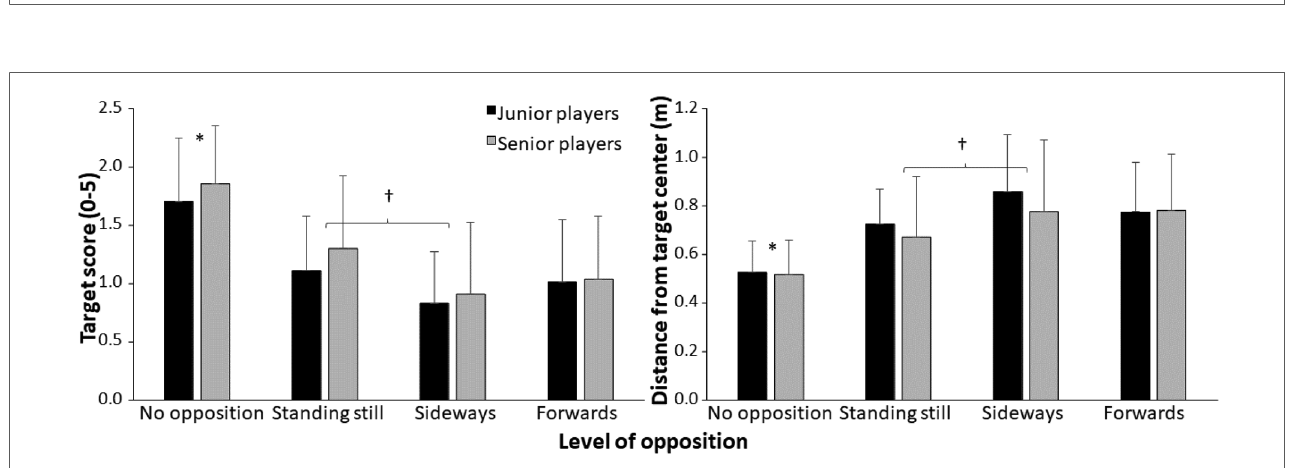
FIGURE 3 Average (±SD) target score and distance from target center over 10 attempts per group and level of opposition. * indicates a signi fi cant difference with all other levels of opposition for both groups on a p <0.05 level. † indicates a signi fi cant difference between these two levels of opposition when both groups were taken together on a p <0.05 level.